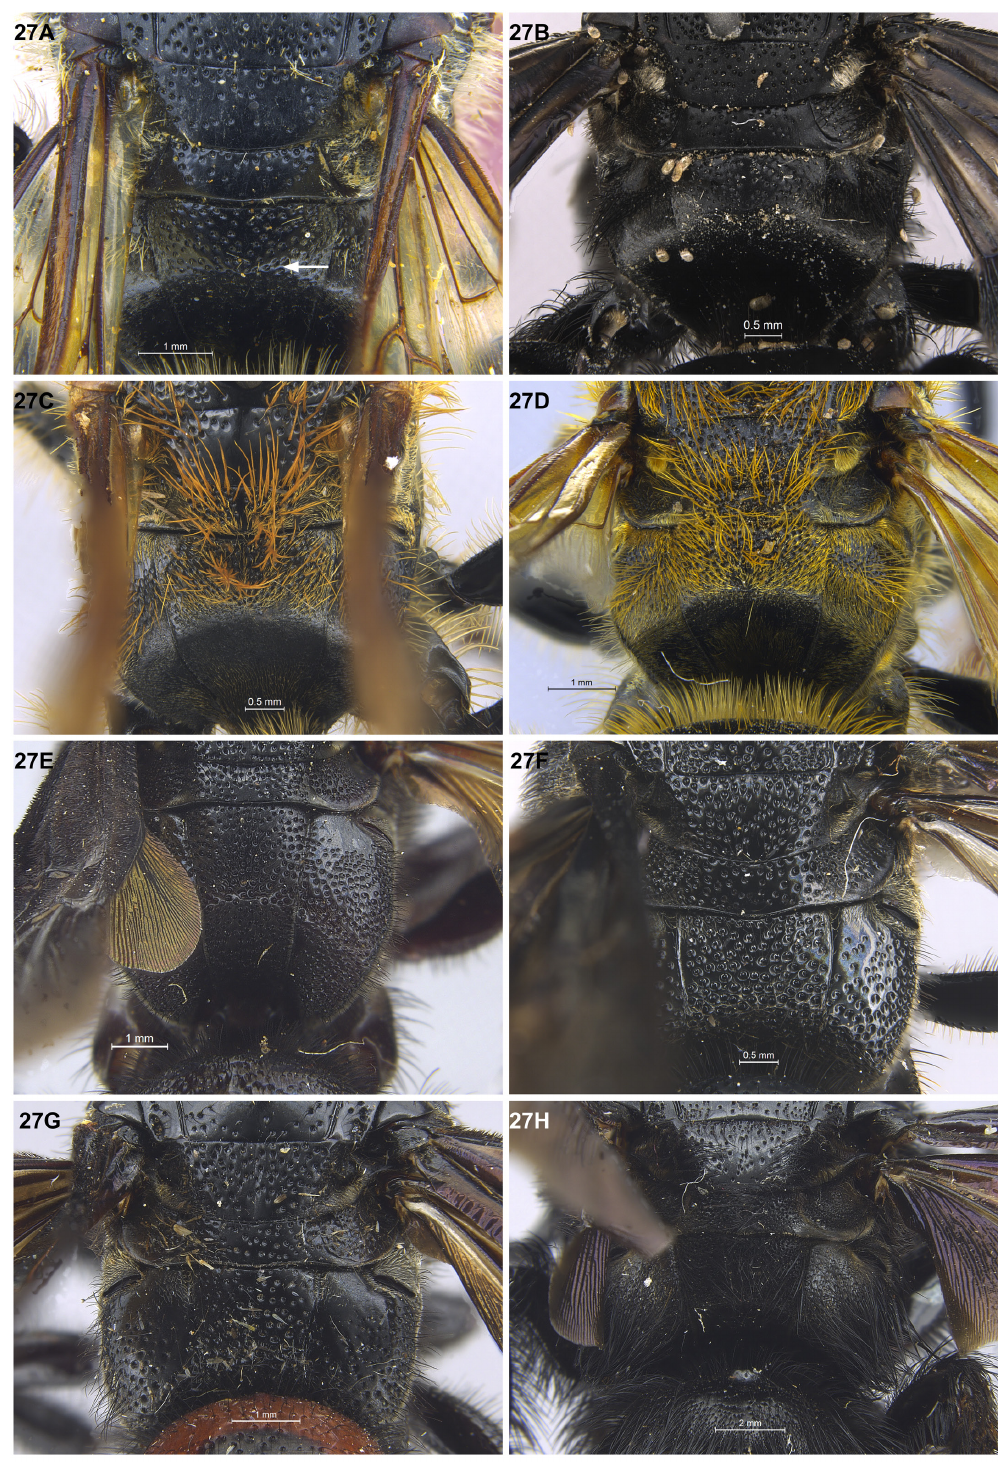
Fig. 27. Females, propodeum. A . Campsomeriella annulata annulata (Fabricius, 1793). B . Camps. collaris (Fabricius, 1775) . C . Megacampsomeris formosensis chinensis Betrem, 1941. D . Phalerimeris phalerata phalerata (de Saussure, 1858). E . Austroscolia ruficeps ruficeps (Smith, 1855). F . Carinoscolia junnanensis (Betrem, 1928). G . Liacos erythrosoma (Burmeister, 1854). H . Megascolia azurea (Christ,